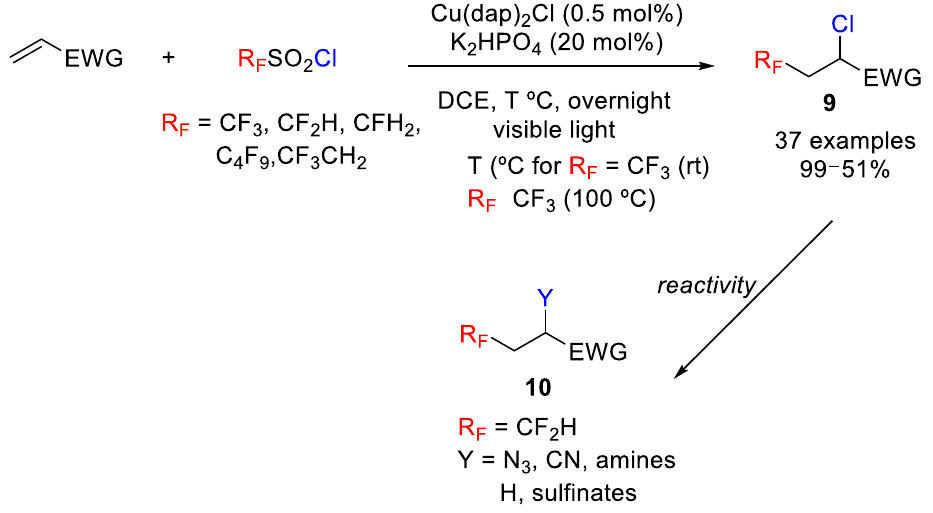
Scheme 9. Reaction of R f SO 2 Cl with electron-deficient